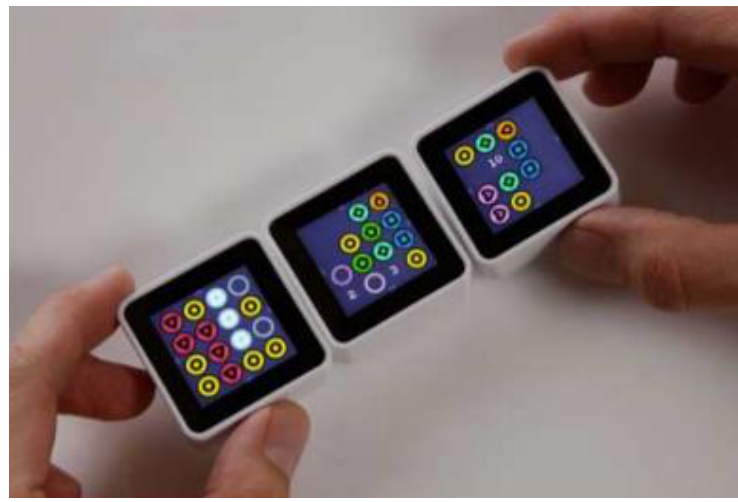
Figure 42. User plays arcade puzzler by Sifteo Cubes [48,78,79].